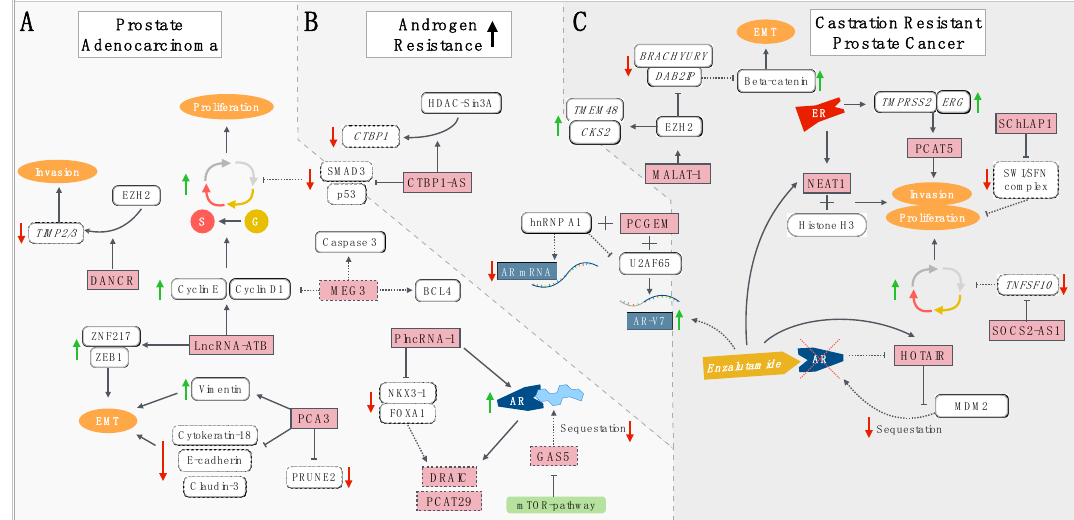
Figure 1. Molecular functions of long non-coding RNAs (lncRNAs) at different stages of prostate cancer, from prostate adenocarcinoma ( A ) to ongoing castration resistance ( B ) to a castration-resistant state ( C ). Dashed squares signify reduced or downregulated proteins/lncRNAs or genes, whilst solid boxes indicate overexpressed or upregulated proteins/lncRNAs or genes. Solid lines signify an active pathway, and dashed lines an inactive pathway. LncRNAs are framed by red, angular shaped boxes. Genes and proteins are framed by white boxes with blunt edges. DANCR: differentiation